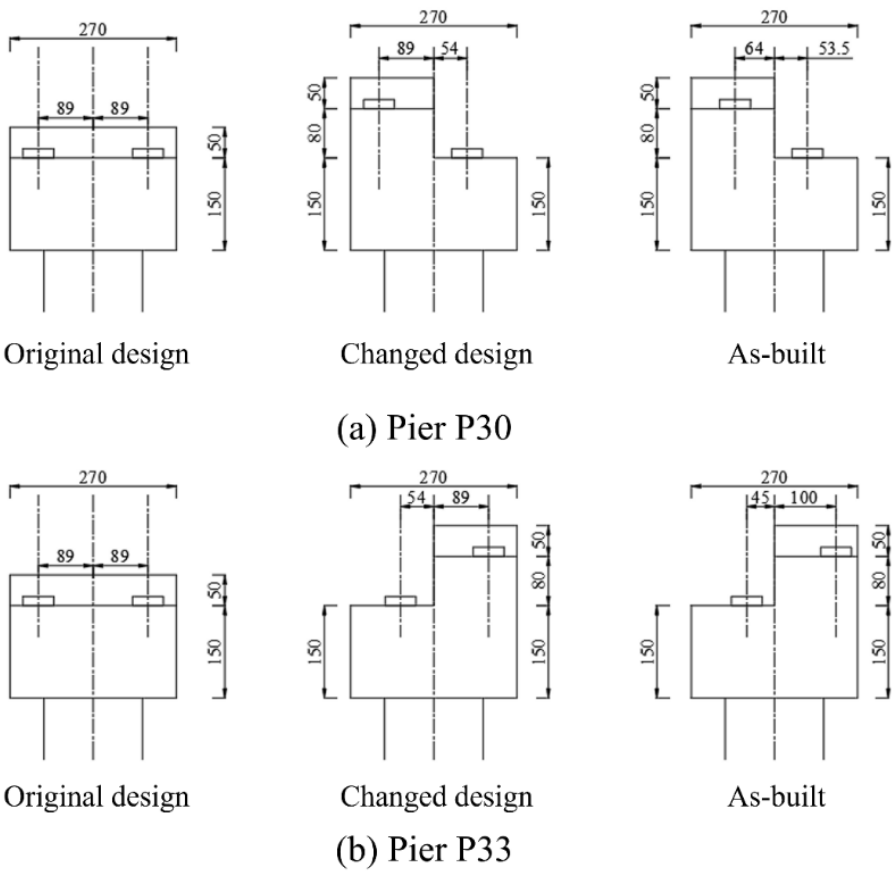
Figure 9. Eccentricities of supports on Piers P30 and P33.